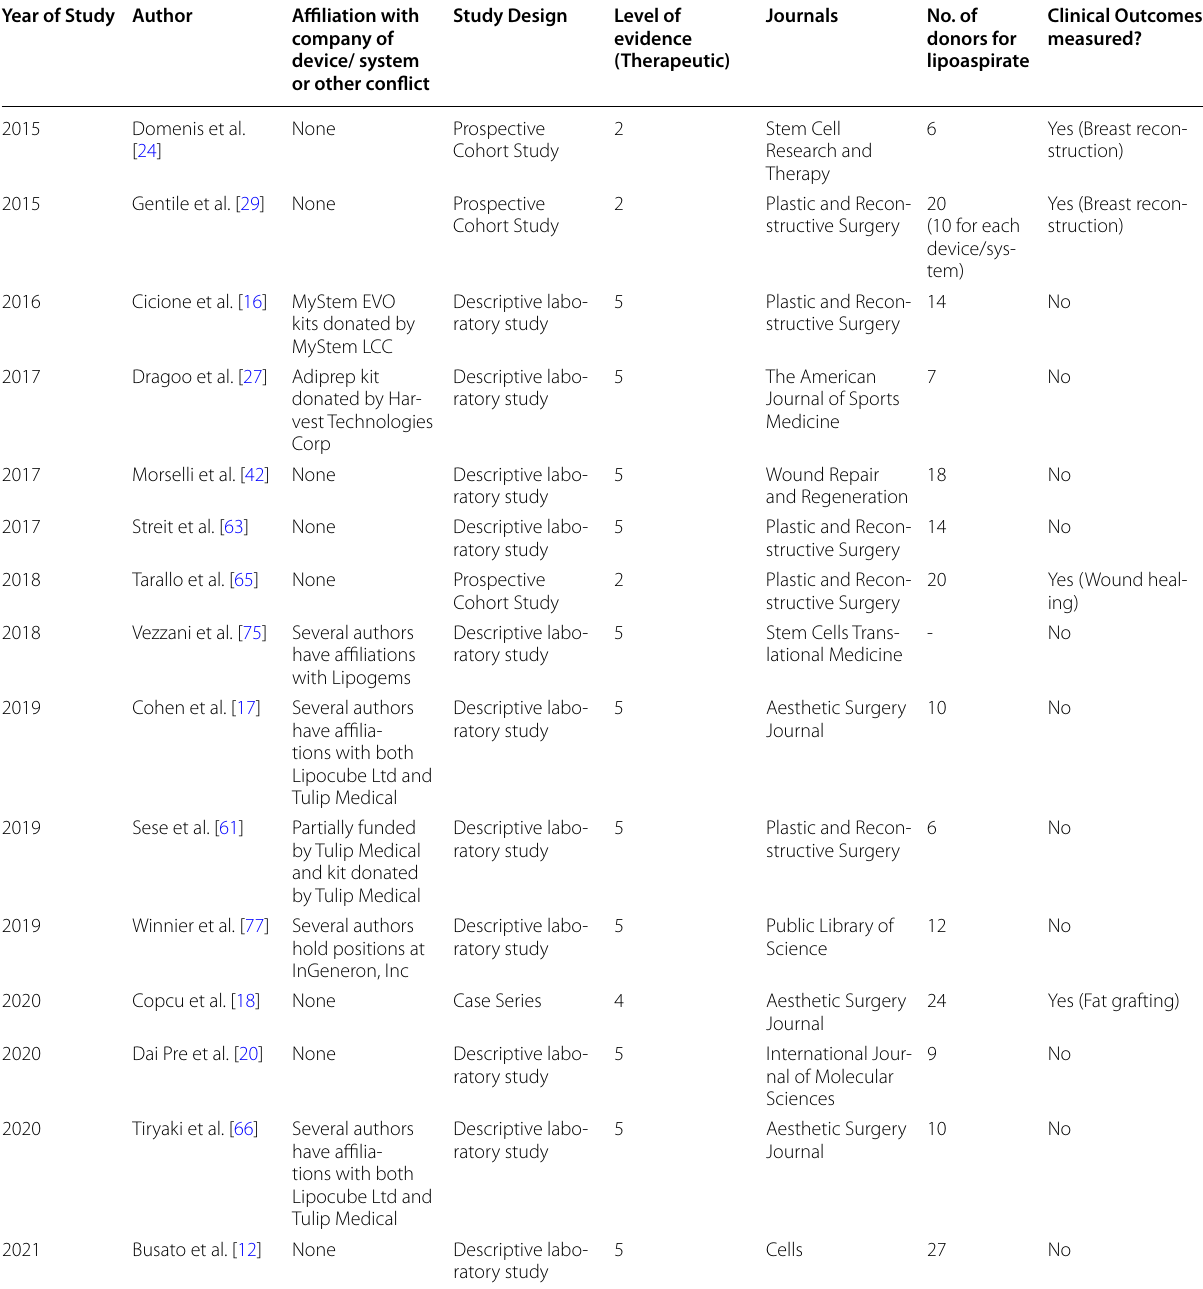
Table 2 List of included publications and their study